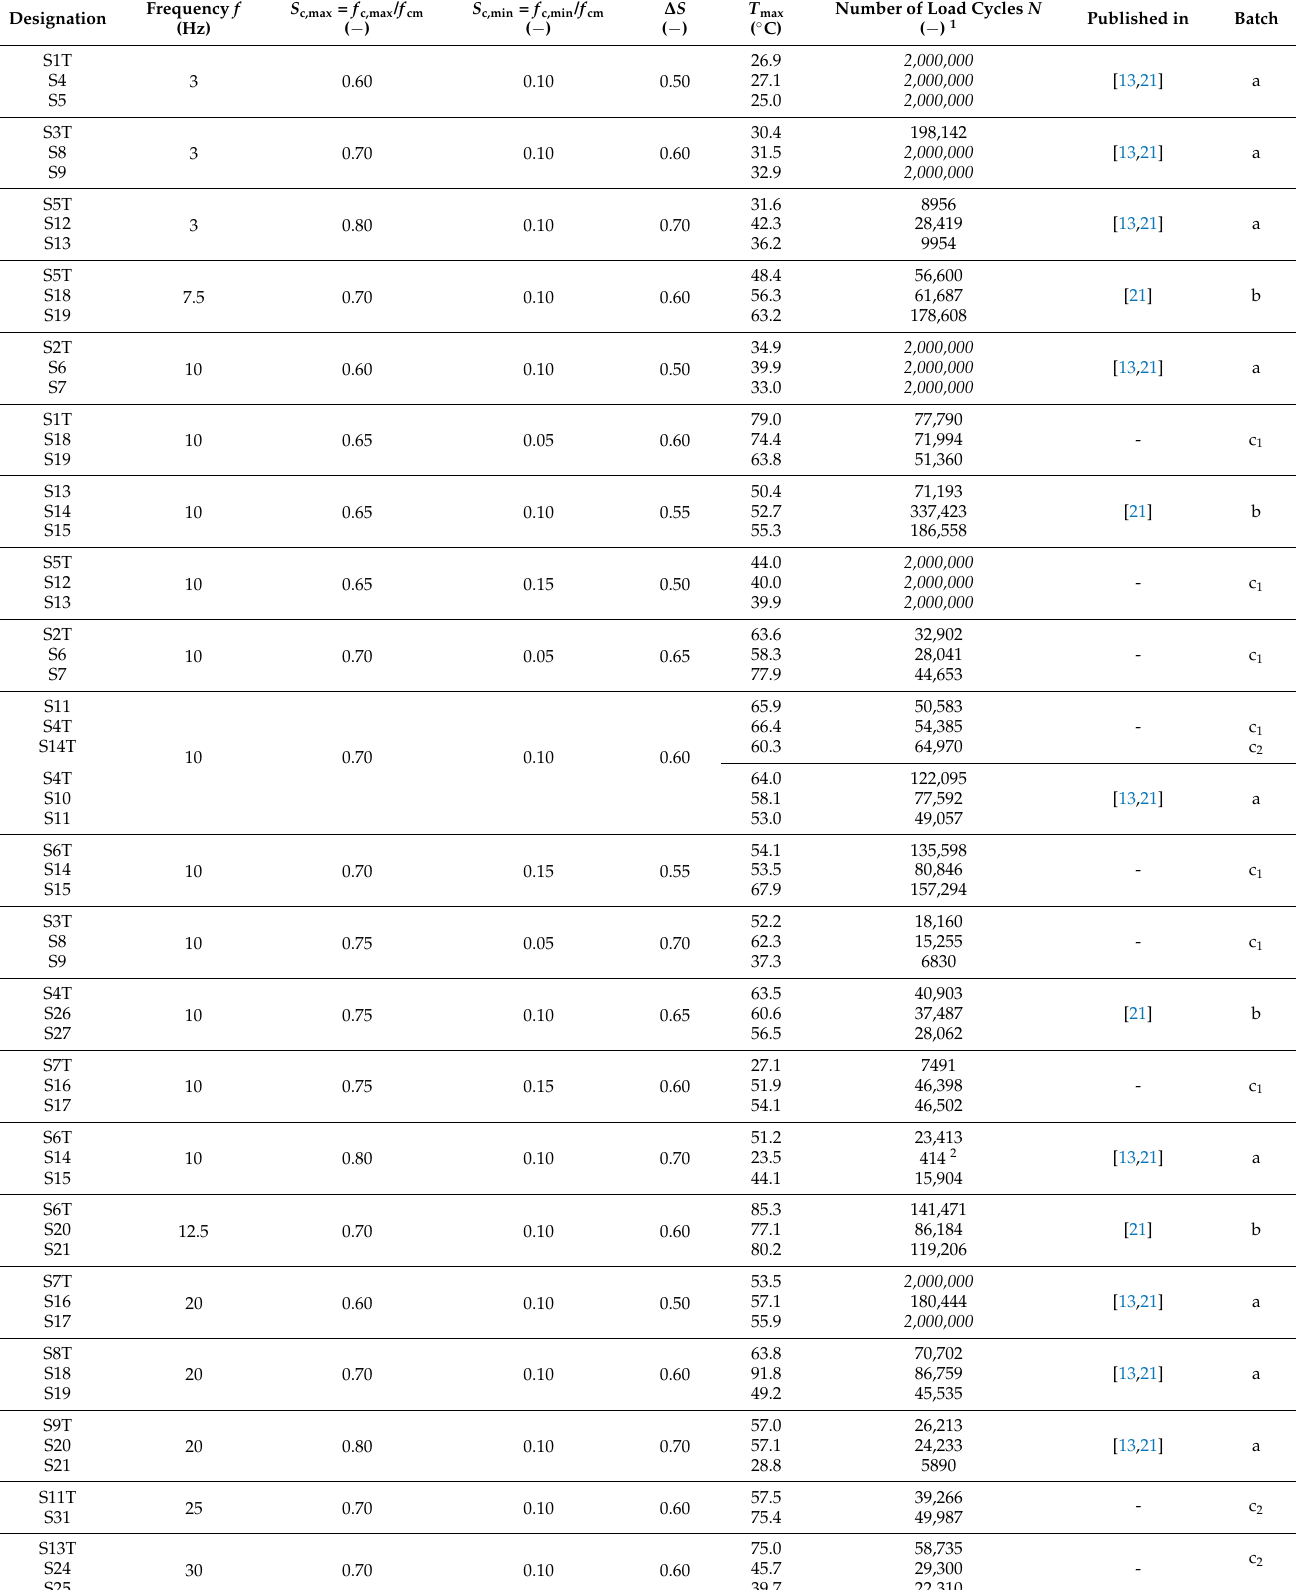
Table 2. Test results that were available as a basis and for the verification of the evaluation